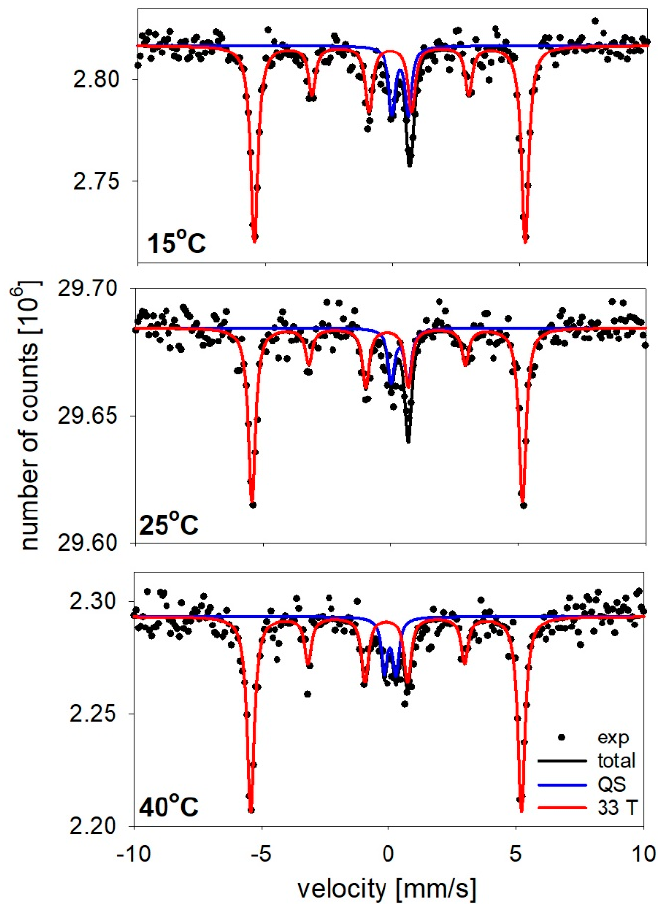
Figure 11. Mössbauer spectra measured at room temperature for the nanowires embedded in the polycarbonate membranes shown along with fitted components: doublet (QS) and sextet (33T). The dominant component of the spectra was a sextet with a relative contribution of about 80%. This component was characterized by a hyperfine magnetic field that was equal to approximately 33 T, an isomer shift (IS) close to − 0.10 mm/s, and nearly 0 vales of quadrupole splitting (QS), which together are typical for bulk-like Fe atoms [81,82]. The contribution to this component came from the Fe nucleus surrounded by Fe atoms that were arranged in a regular structure. The 0 value of quadrupole splitting especially suggests rather relatively large grains with a well-ordered cubic structure. The second- and third-line intensity ratio (A2/A3), which is shown in Table 1, provides information regarding the relationship between the γ -ray propagation and the magnetization vector orientation ( θ ). The estimated value of θ varied from 30 ◦ to 33 ◦ , which indicated the deviation of the magnetization vector from the normal direction. The second component of the spectrum was a doublet with a relative contribution of about 20%. This component was defined by an isomer shift and quadrupole splitting. The doublet indicated Fe atoms in a paramagnetic or superparamagnetic state. While the sextets were assigned to Fe atoms inside the nanowires, the doublets could be associated with the Fe atoms at the edges or in the voids, in which there were a limited number of Fe atoms in a ferromagnetic state in the close neighborhood of the